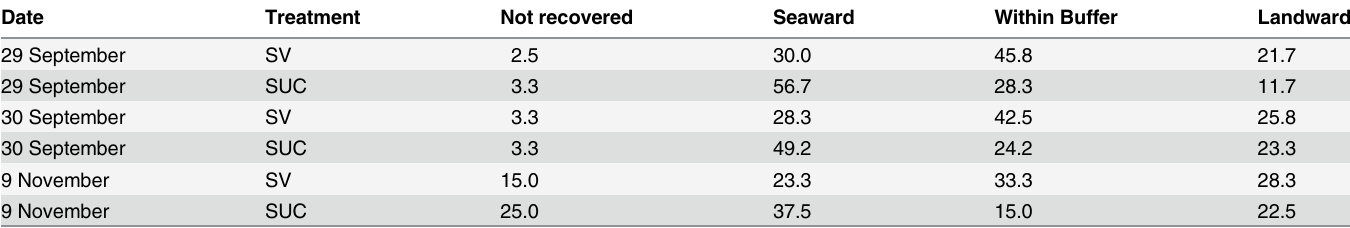
Table 4. Fate of A . germinans propagules in experiment.